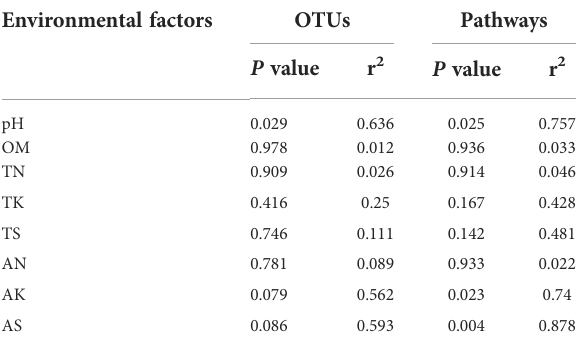
TABLE 3 Contribution of environmental factors to OTUs and